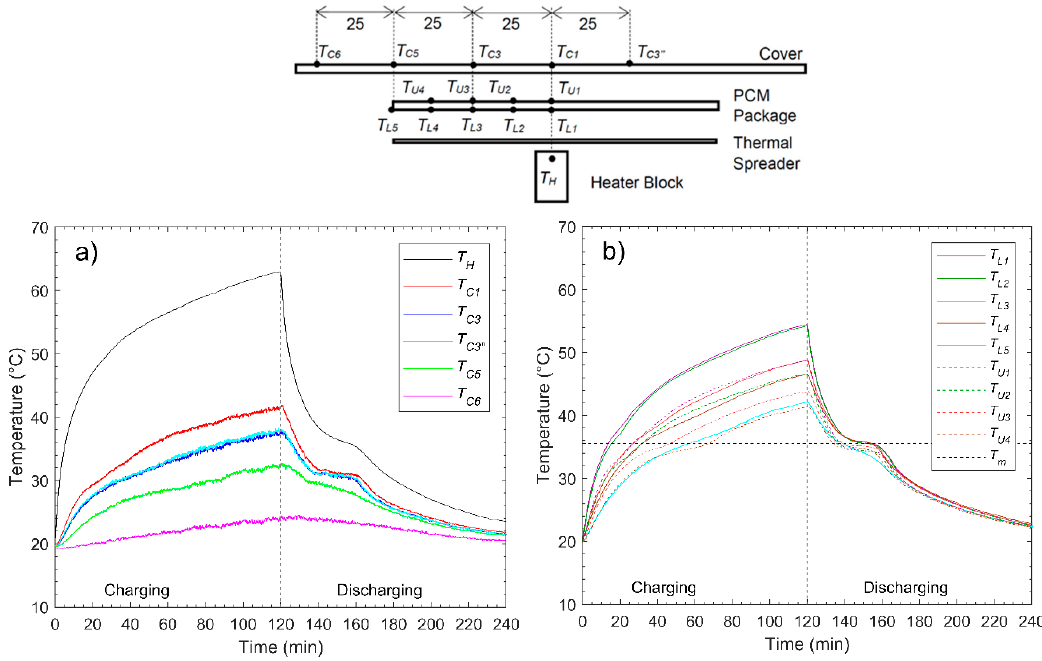
Figure 7. ( a ) Temperature profile of the heater ( T H ) and the cover surface ( T C ). ( b ) Temperature profiles of the upper ( T U1 –T U4 ) and lower ( T L1 –T L5 ) surface of the PCM package A ( n -eicosane) and thermal of the upper ( T U 1 – T U 4 ) and lower ( T L 1 – T L 5 ) surface of the PCM package A ( n -eicosane) and thermal spreader for the experiment with a constant power input of 5 W for 120 min. spreader for the experiment with a constant power input of 5 W for 120